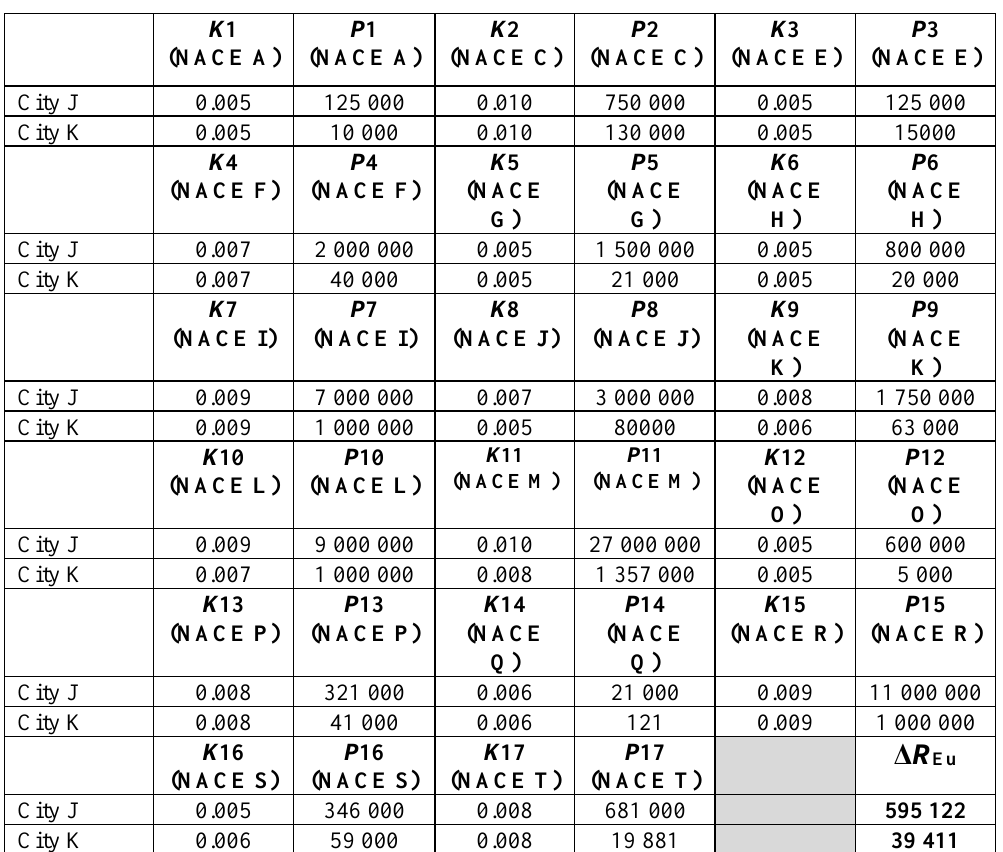
Table 6. Additional Income Calculation from Urbanisation Δ R (developed by the authors)